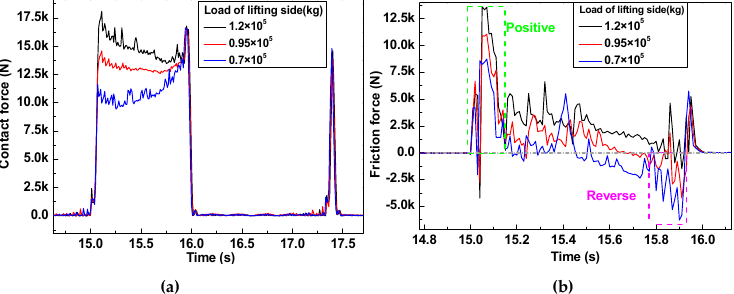
Figure 19. Contact and friction force between the 369th rope element (400 m) and the friction pulley. ( a ) Contact; ( b ) friction.